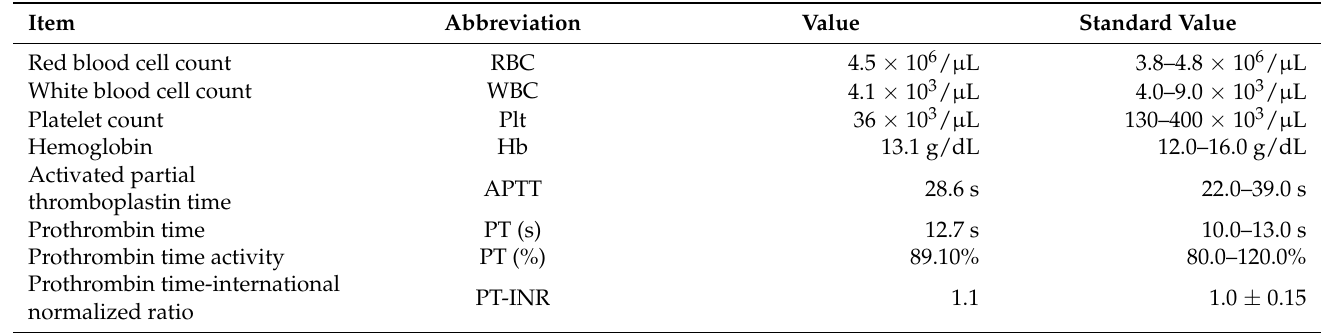
Table 2. Results of the preoperative blood analysis.